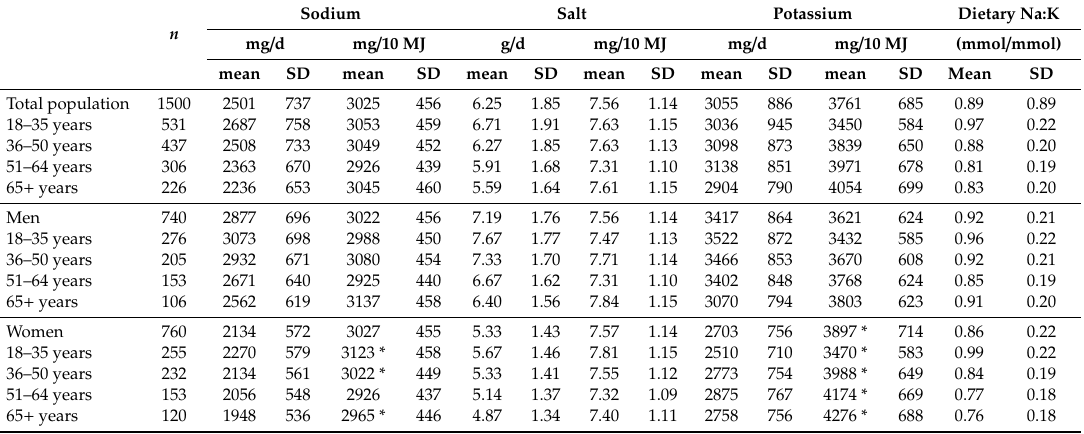
Table 2. The mean daily intakes of sodium, salt and potassium and dietary molar Na:K in Irish adults ( n =